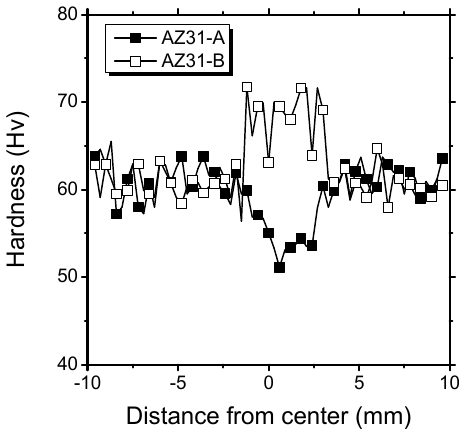
Figure 7. Hardness profile for BOP welding.